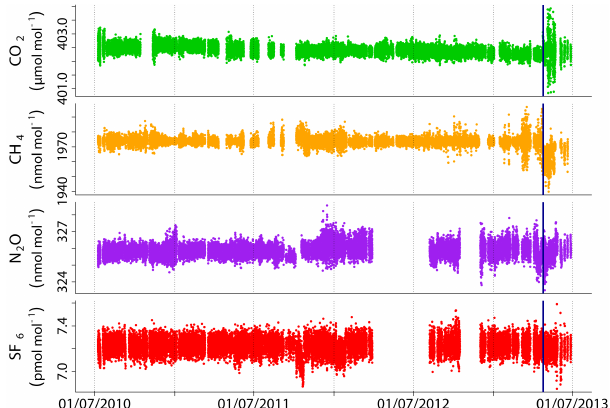
Figure 4. Time series of the target gas measured with the GC system at Puy de Dôme. The vertical blue lines in each panel correspond to the date of the working standards change.